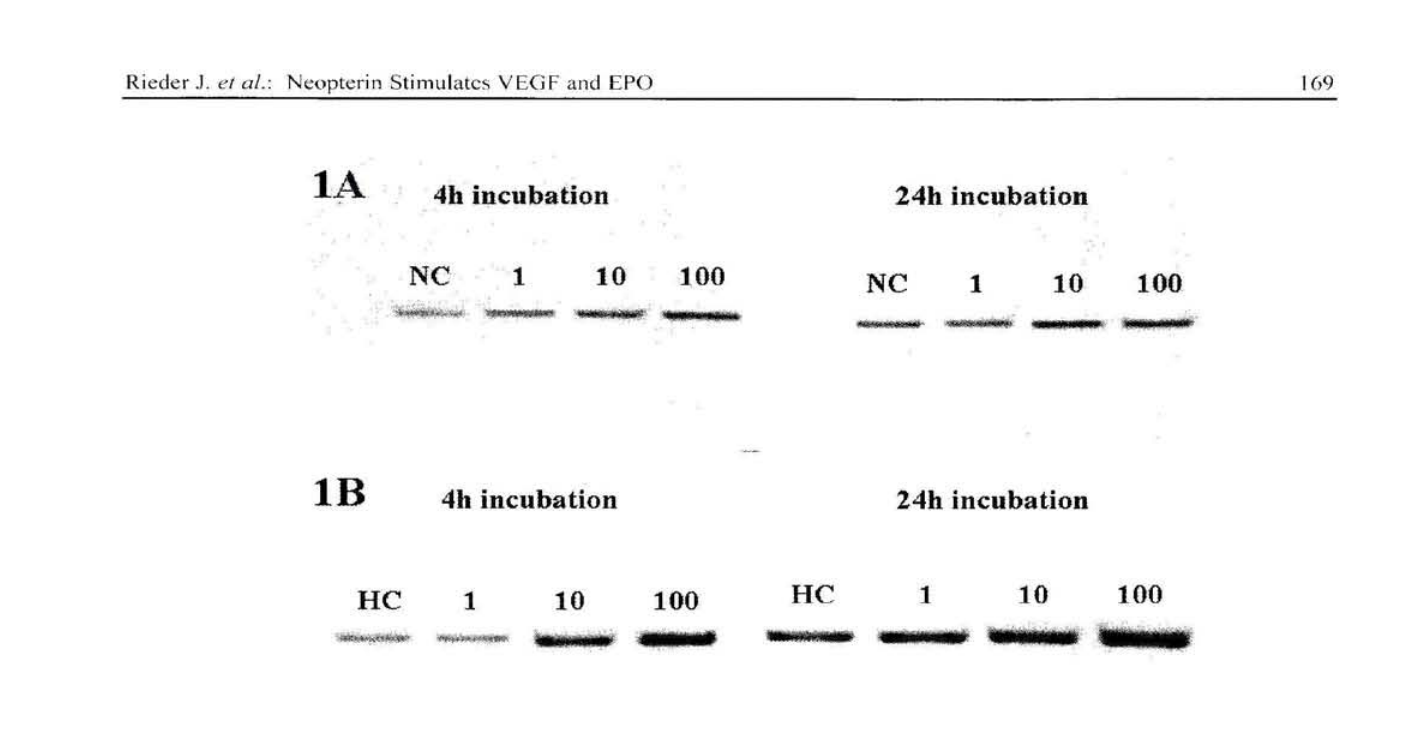
Figure 1. Qualitative analyses of vascular endothelial growth factor (VEGF) gene expression detected as VEGF- cDNA (fragment size 342 base pairs) in OVCAR-3 cells incubated for 4 h and 24 h with neopterin at concentra- tions of 1 μΜ ( 1 ), 1 0 μΜ ( 1 0), and 100 μΜ (100), respectively. Cells were incubated under either normoxic con- ditions (Figure 1 A) in an atmosphere of 5% ( < ) . in air or under hypoxic conditions (Figure 1 B) with a pre-mixed gas of 5% C0 2 , 2% 0 2 , and 93% N 2 . NC and HC indicate normoxic and hypoxic control incubations performed without neopterin. Results are representative of five different incubations.